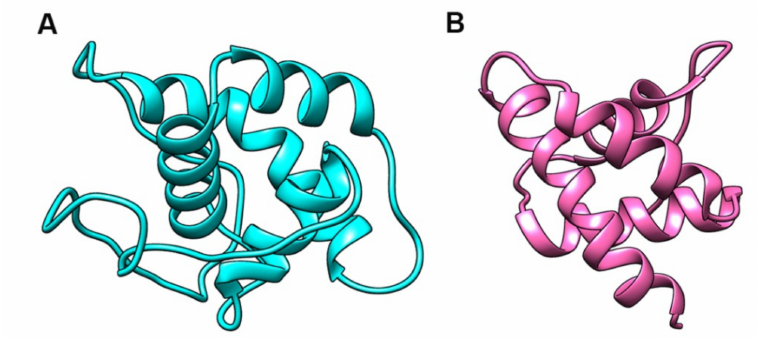
Figure 7. The predicted three-dimensional (3D)-structure of OsHyPRP16 protein. ( A ) Mature OsHyPRP16 (without signal peptide). ( B ) Proline-rich region fragment deleted